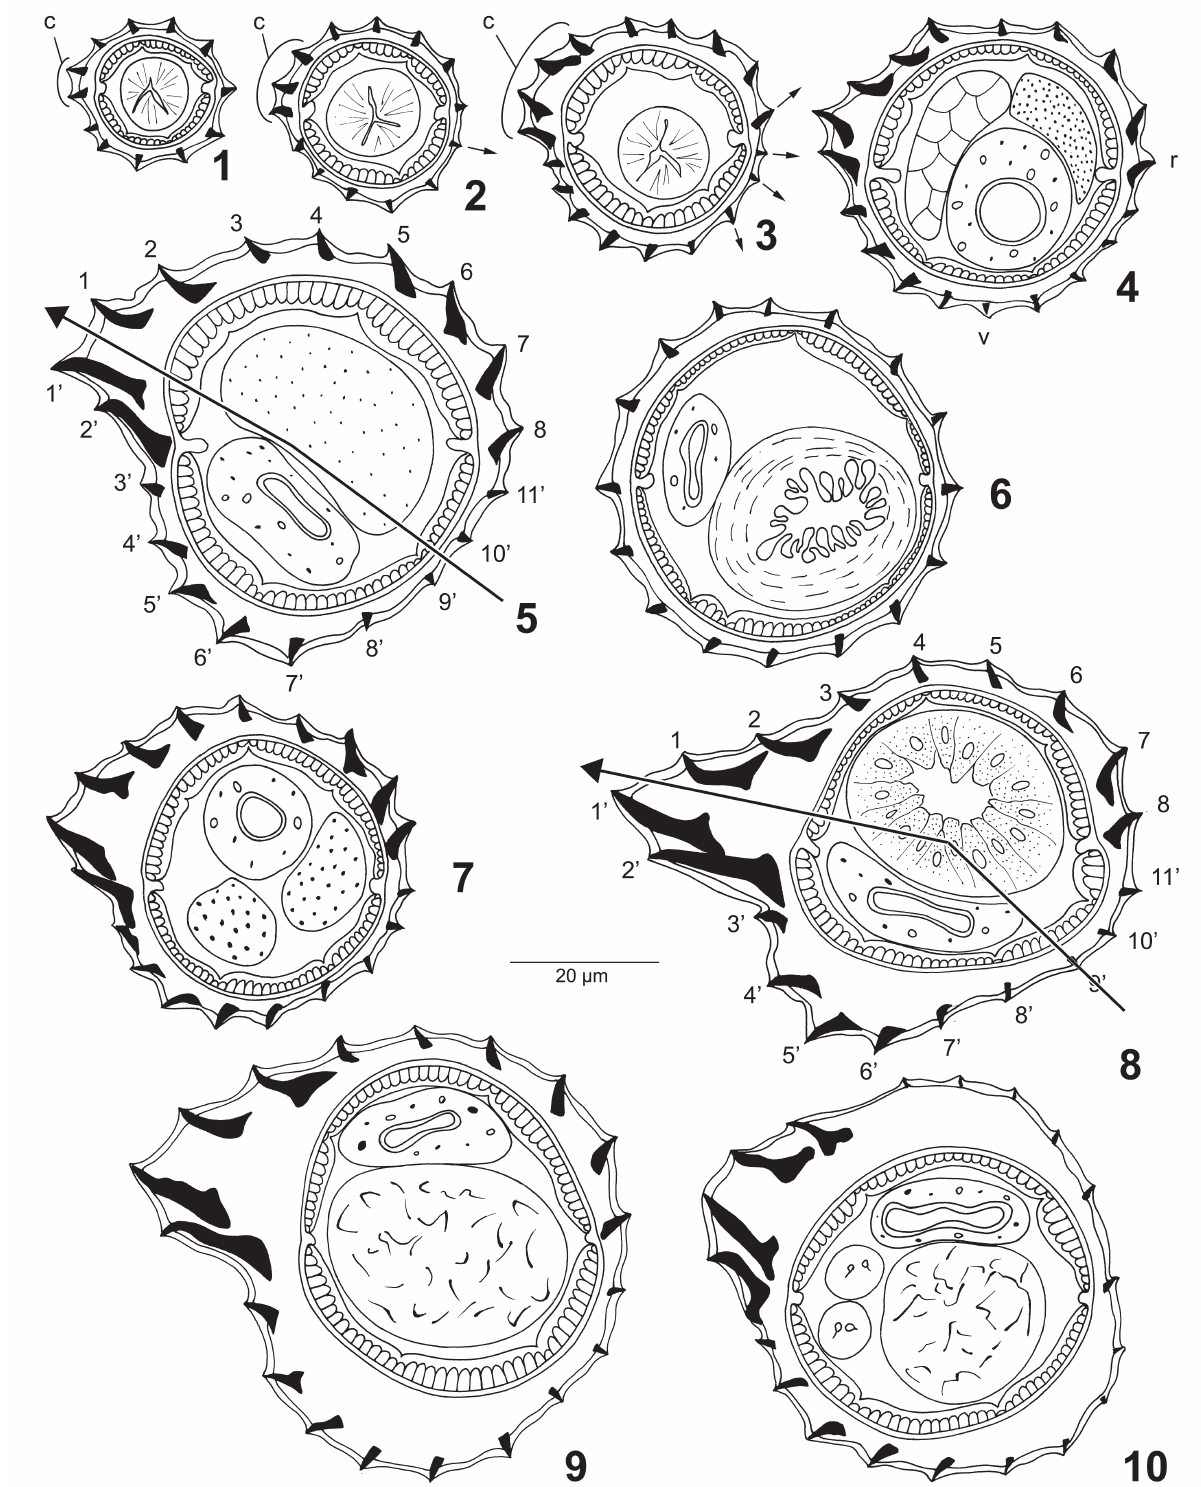
1-10. – Heligmonoides variabilis n. sp. 1, transverse sections of body. 1-6: paratype female, 2.55 mm long. 1, just posterior to cephalic vesicle; 2, at 80 µm posterior to cephalic vesicle; 3, at level of nerve ring; 4, at level of oesophageal intestinal junction; 5, at mid-body (1.1 mm from apex); 6, at level of infundibulum. 7-10: paratype male, 2.4 mm long. 7, at level of oesophageal intestinal junction; 8, at mid-body (1.2 mm from apex); 9, at 350 µm anterior to caudal bursa; 10, at 200 µm anterior to caudal bursa. Abbreviations. – c: carene; r: right side; v: ventral side. The long arrows represent the axes of orientation, double in male, single in female. The short arrows directed away from the body indicate the origin of a ridge. The ridges are numbered in relation to the frontal axis (pas- sing through the lateral fields) and not in relation to the axes of